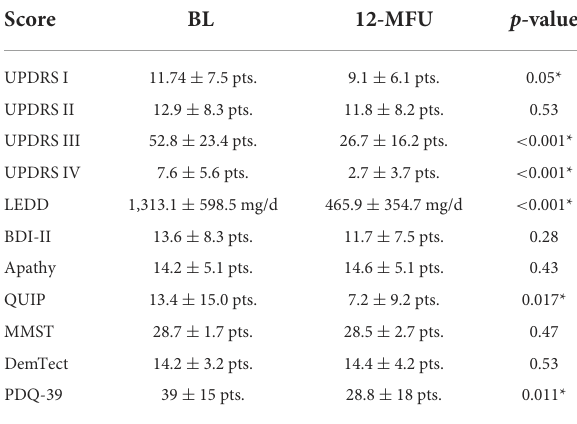
TABLE 1 Baseline (BL) as well as 12-months follow-up (12-MFU) results of motor and non-motor symptoms including mood, apathy, impulsiveness and cognition as well as PDQ-39-summary index representing quality of life changes in the total cohort of 46 Early-Onset-Parkinson’s disease patients given in mean ± standard